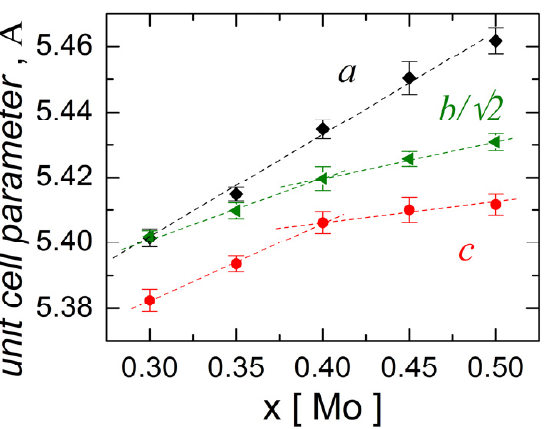
Figure 2. The dependence of a , b and c unit cell parameters ( Pnma space group) of CaV 1–x Mo x O 3– δ on Mo concentration.